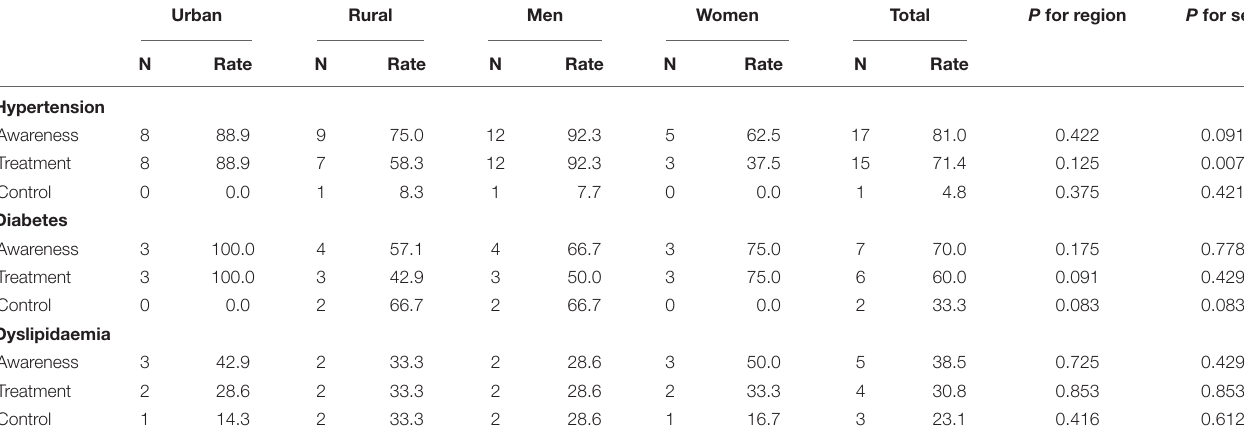
TABLE 4 | Awareness, treatment, and control of main chronic diseases in 25 people with atrial fibrillation (AF) in northeast China. Urban Rural Men Women Total P for region P for sex